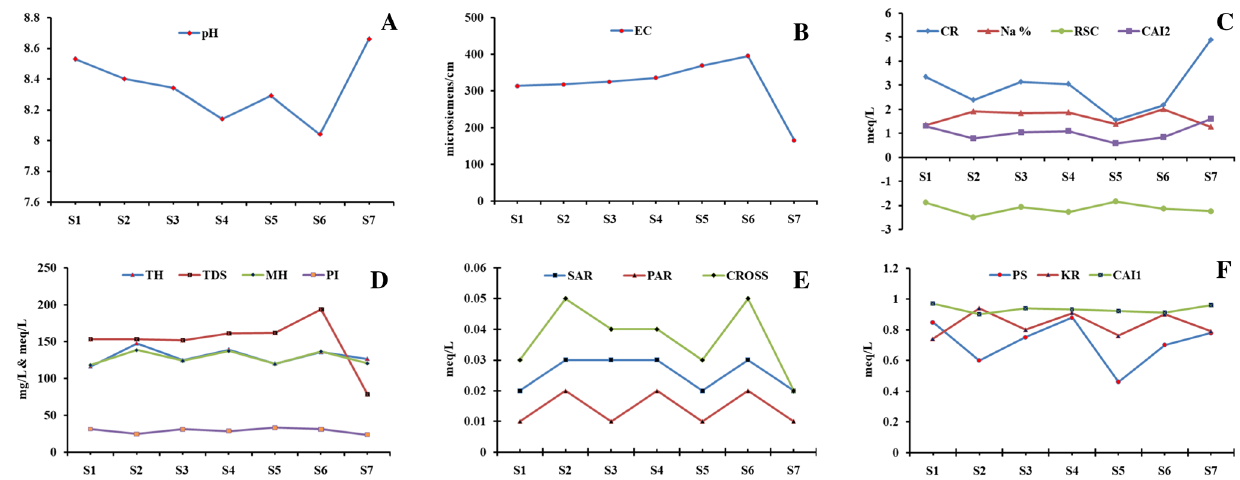
Fig. 2 A–F Graphical representation of different irrigation water indexes of different sites from high altitude (Leh, Ladakh, India). EC Electrical Conductivity’ TDS Total Dissolved Solids, TH Total Hard- ness, PS Potential Salinity, Na % Sodium Percentage. MH